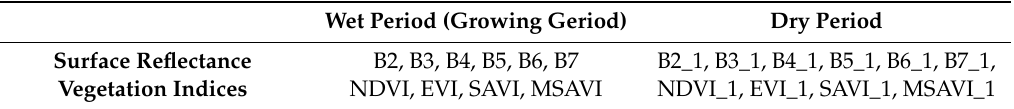
Table 2. Predictors used in the Random Forest classification.